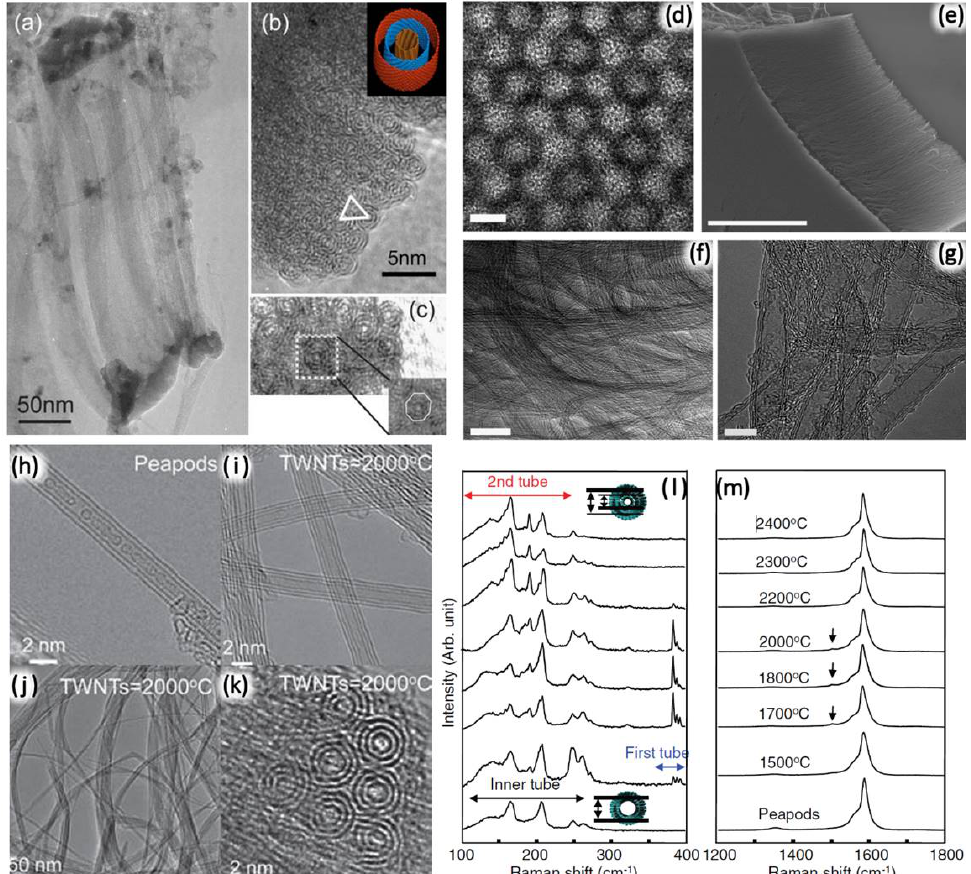
Figure 8. Synthesis of triple-walled carbon nanotubes (TWNTs) using various methods. Catalytic chemical vapor deposition (CCVD)-synthesized TWNT ring. Reproduced with permission from [144], Copyright AIP Publishing LLC, 2006. Low ( a ) and high ( b ) magnification TEM image of a TWNT ring. TWNTs are packed into a triangular configuration ( b ) and faceted TWNTs within the ring ( c ). Vertically-aligned TWNT grown from engineered hollow nanoparticles (HNPs) by plasma-enhanced CVD (PECVD); ( d ) hollow nanoparticles used as a catalyst; the scale bar represents 5 nm ; ( e ) SEM image of vertically-aligned TWNTs; the scale bar represents 10 nm; ( f ) low and ( g ) high magnification TEM images of TWNTs; the scale bars represent 50 and 5 nm, respectively. Reproduced with permission from [147], Copyright American Chemical Society, 2014. DWNT pea pod-derived TWNTs; TEM images ( h )–( k ) and Raman spectrum ( l )–( m ). Reproduced with permission from [149], Copyright John Wiley and Sons, 2011. High magnification image of C 60 -encapsulated DWNTs ( h ) and TWNTs formed by high temperature annealing at 2000 ◦ C ( i ). The generation of peaks at 380 cm − 1 in ( l ) confirms the formation of the inner most tube of TWNTs by annealing over 1500 ◦ C, especially between 1700 ◦ C and 2000 ◦ C (m)